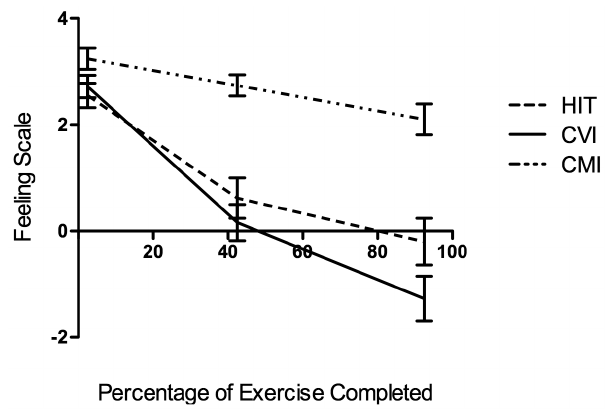
Figure 2. Feeling Scale responses (M ¡ SE) during the three exercise